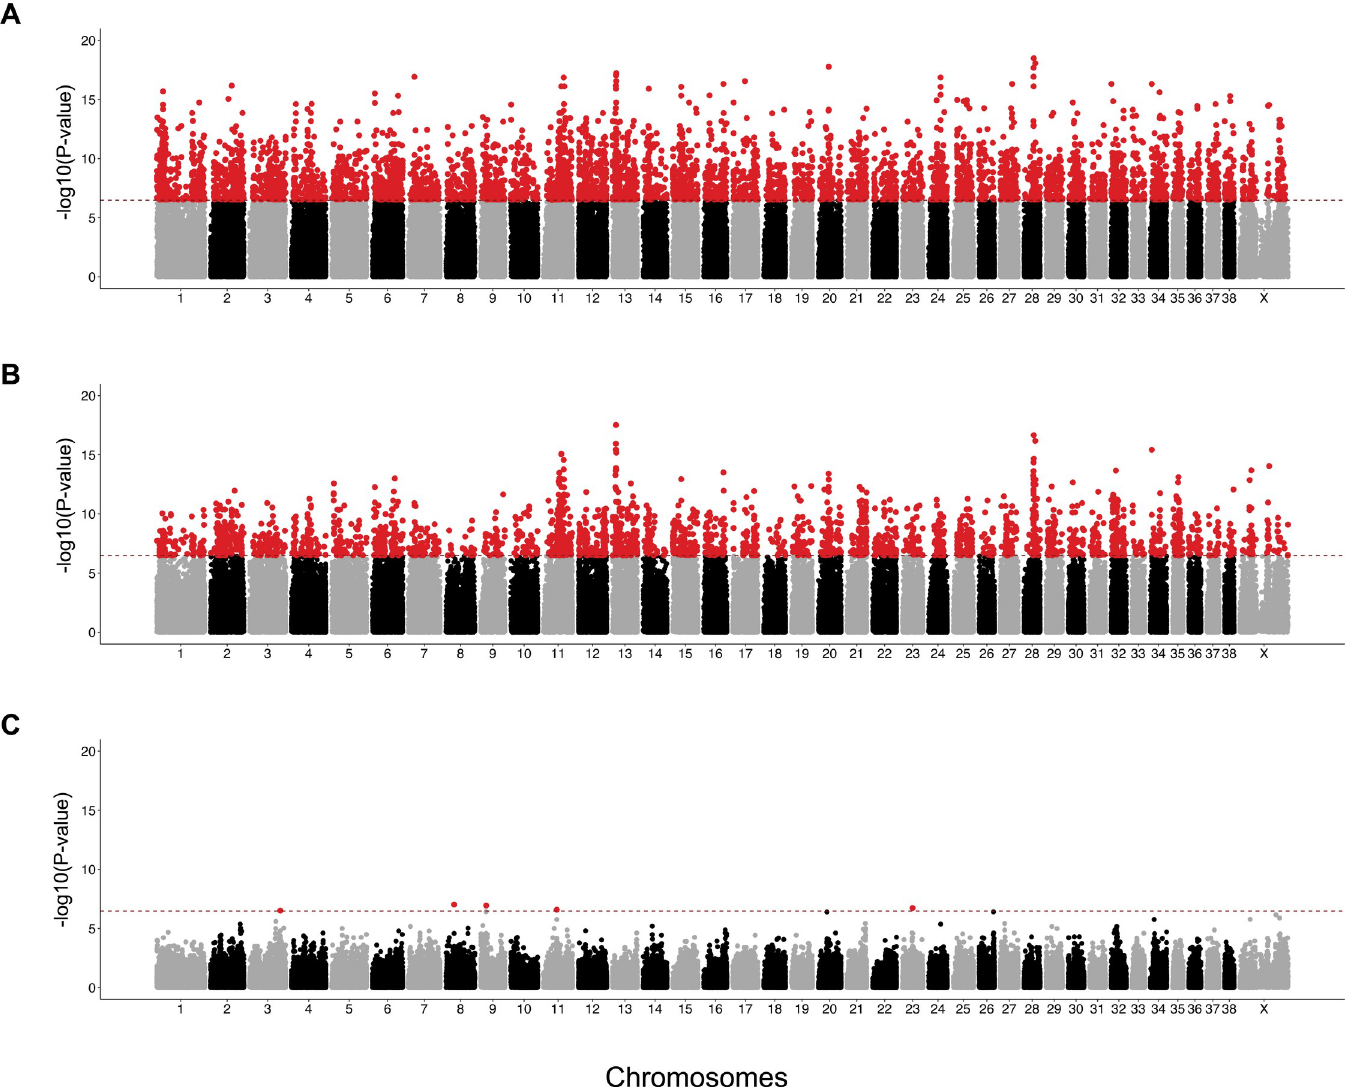
Fig 6. Genome-wide identification of variants with significant allele frequency differences between breeds. (A) Manhattan plot for the POOD vs. LAB allele frequency comparison reveals allele frequency differences on chromosome 13 in a region containing RSPO2 (peak SNP chr13:8635445) and on chromosome 28 in the region containing ADRB1-AU1 (peak SNP chr28:24866296). (B) Manhattan plot for ALBD vs. LAB, identifying loci on chromosomes 13 and 28. (C) Manhattan plot for ALBD vs. POOD. Five significant SNPs are noted on chr 3, 8, 9, 11 and 23. The red line represents the Bonferroni corrected significance threshold (-log 10 (P) = 6.48) and SNPs passing this threshold are colored in